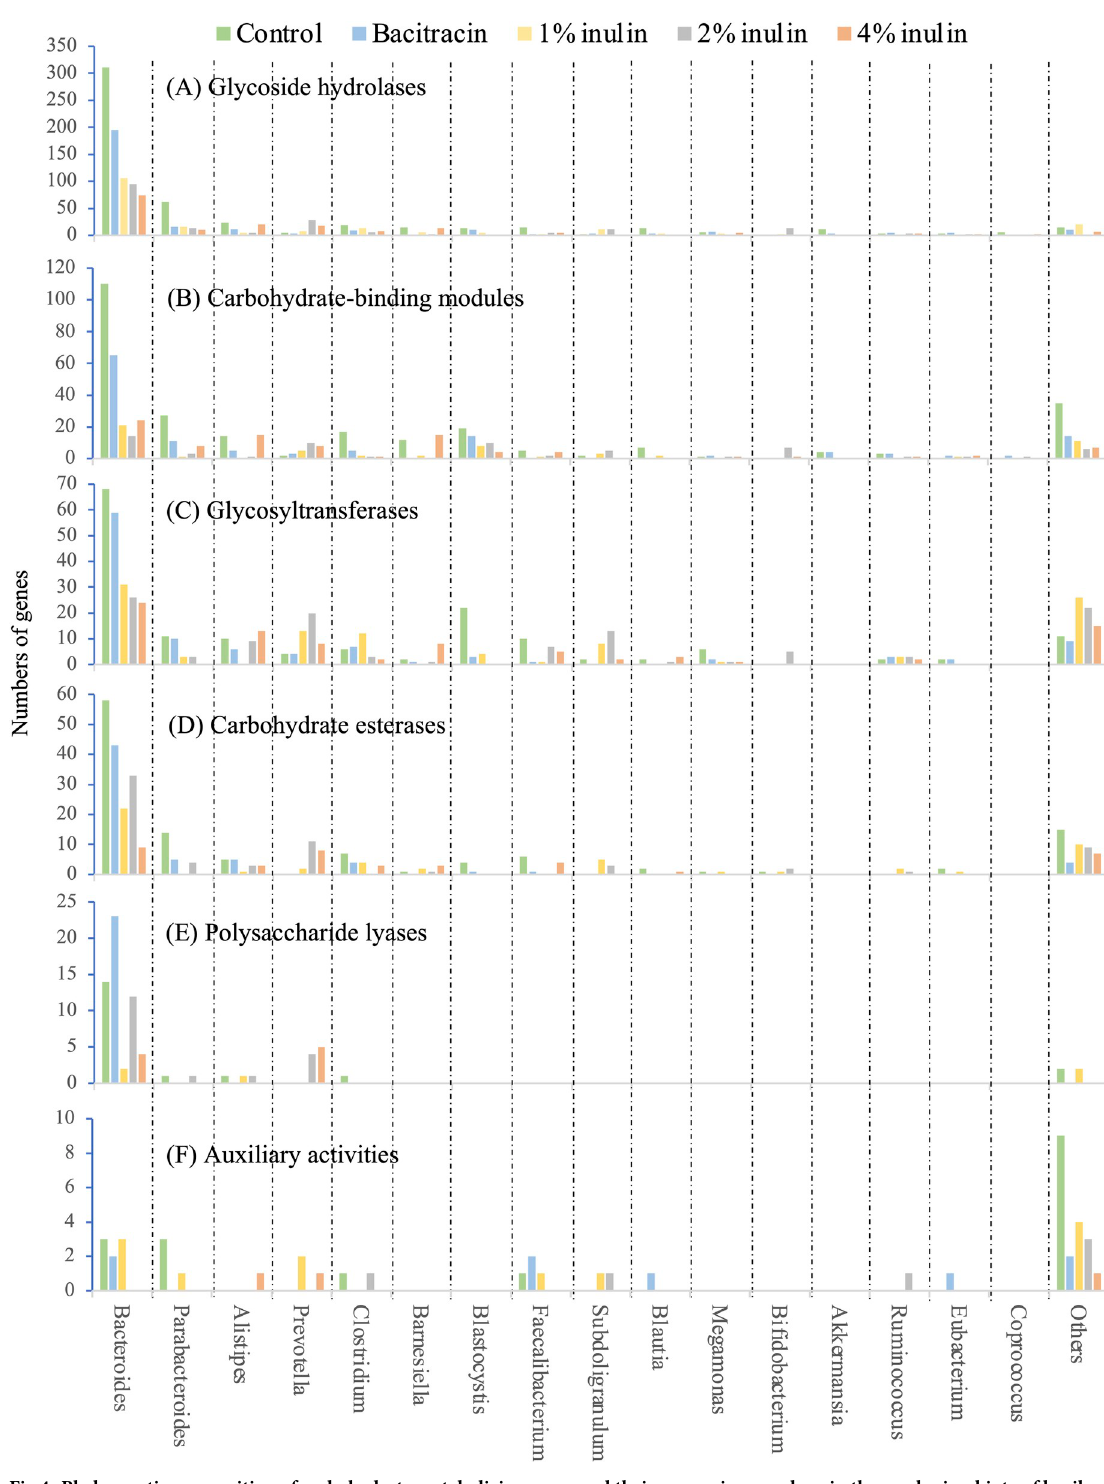
PLOS ONE | https://doi.org/10.1371/journal.pone.0258663 October 21,